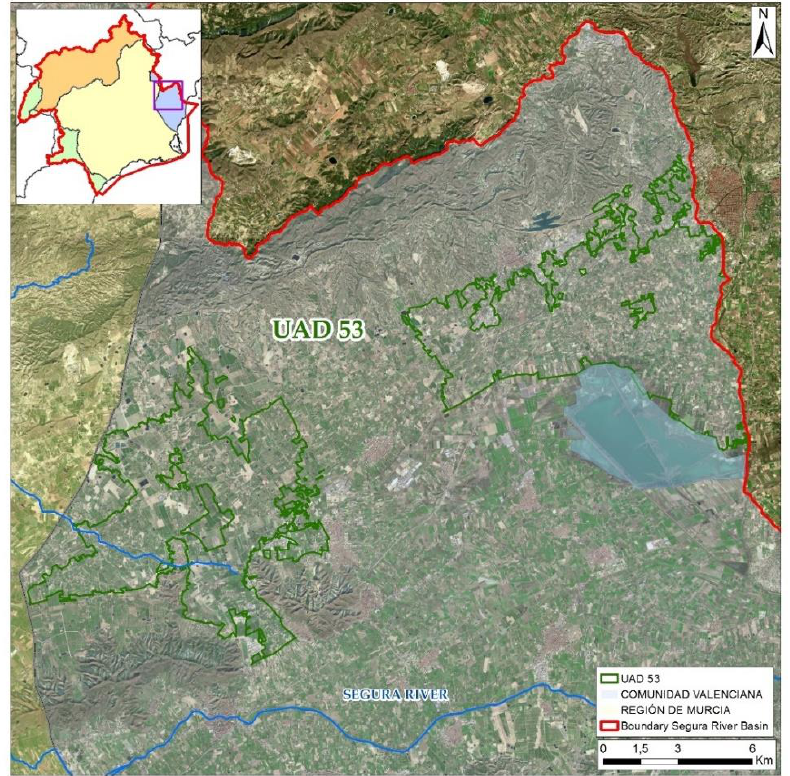
Figure 2. Unit of agricultural demand (UAD) 53 situation map. Source: Segura River Basin Hydrological Plan (SBHP) 2015/21, Own elaboration.